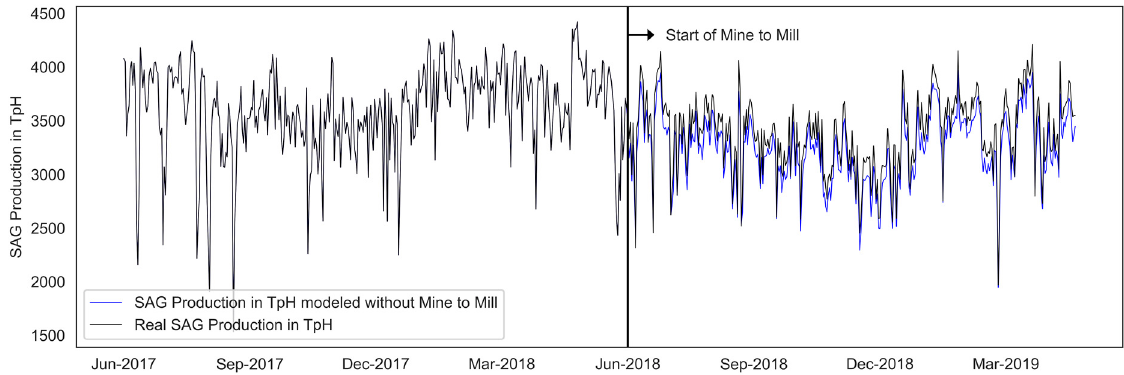
Figure 6. Average production of an SAG mill in tons per hour.